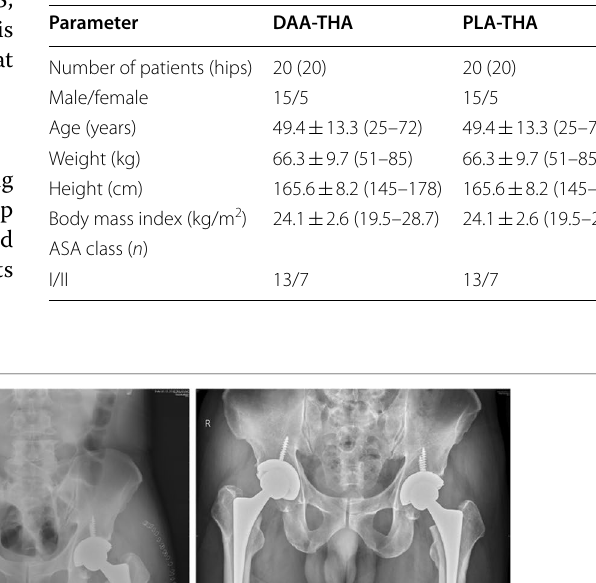
Table 1 Detailed demographic data of